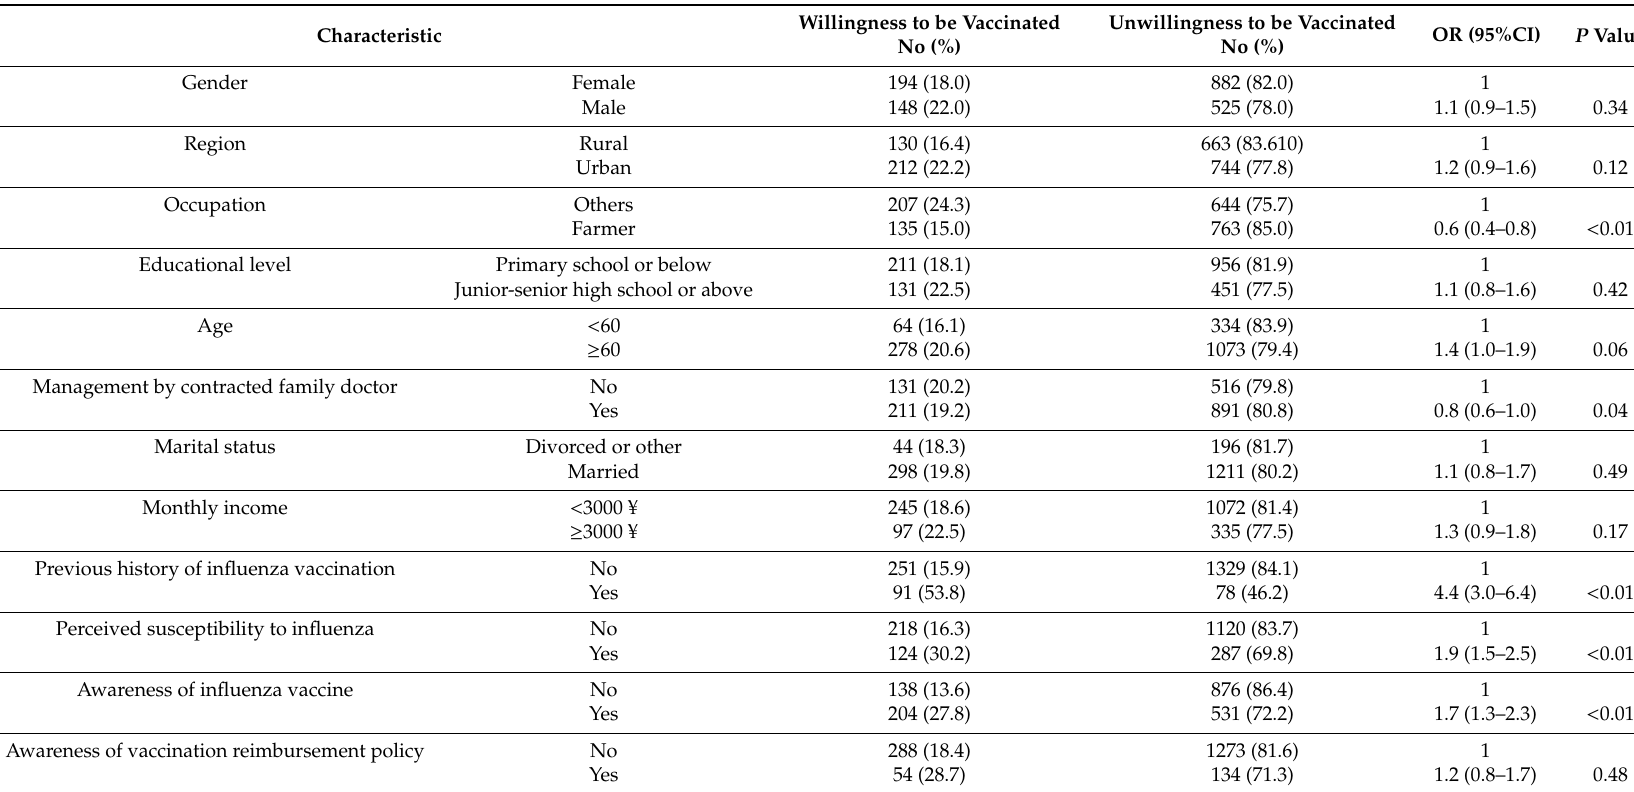
Table 3. Multivariable logistic regression analysis for influential factors associated with T2DM patients’ willingness to receive seasonal influenza